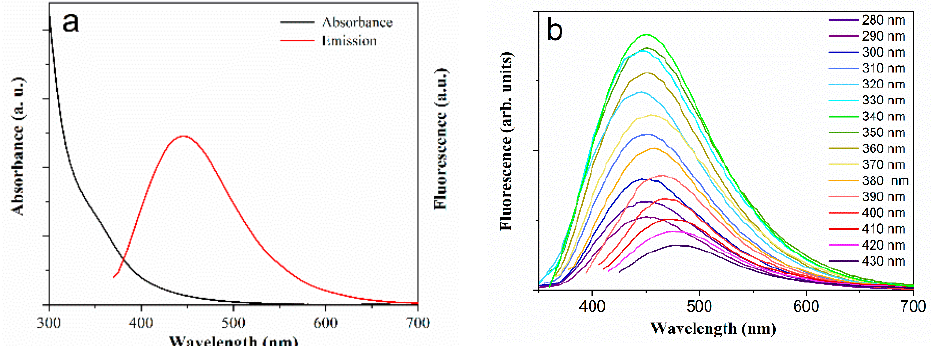
Figure 3. ( a ) UV-vis absorption spectrum (black curve) and fluorescence spectrum (red) of N-CDs- W-THF solution excited at λ exc = 355 nm; ( b ) emission spectra at different excitation wavelengths.